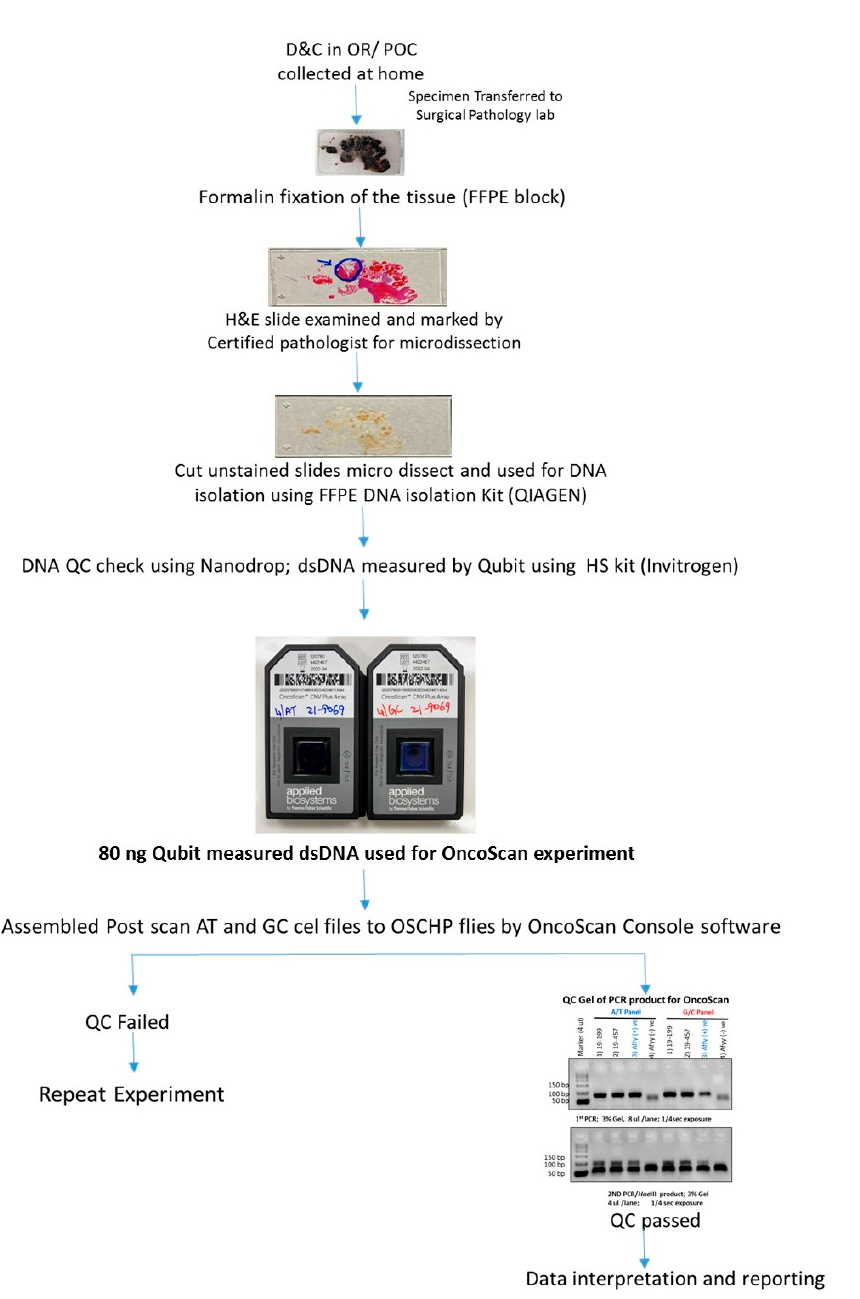
Figure 3. Flowchart depicting the detailed workflow for MCC-positive POC tissue with histological assessment and OncoScan microarray analysis and reporting.